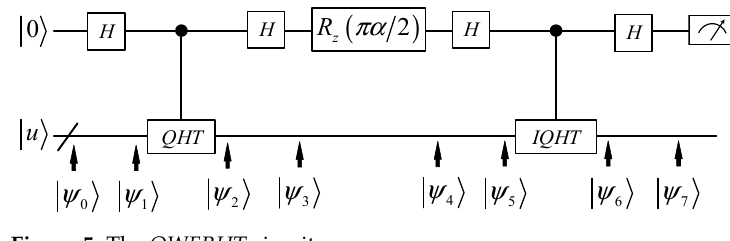
Figure 5. The QWFRHT circuit.